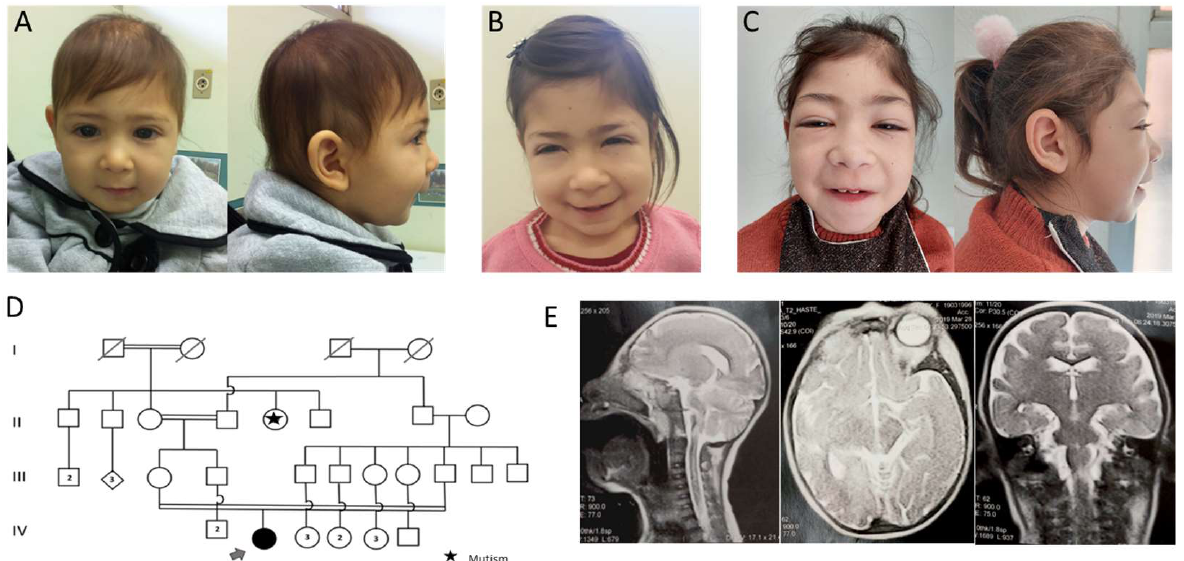
Figure 1. ( A – C ) Pictures of the patient at 2 years, 6 years, and 9 years of age, respectively, showing no relevant dysmorphisms besides microcephaly. Closed eyes point to photophobia. ( D ) Four-generation pedigree of family showing multiple consanguineous unions. Proband’s parents are first cousins and her mother was also born to consanguineous parents. ( E ) Brain nuclear magnetic resonance showing parenchyma with volumetric decrease and lissencephaly.